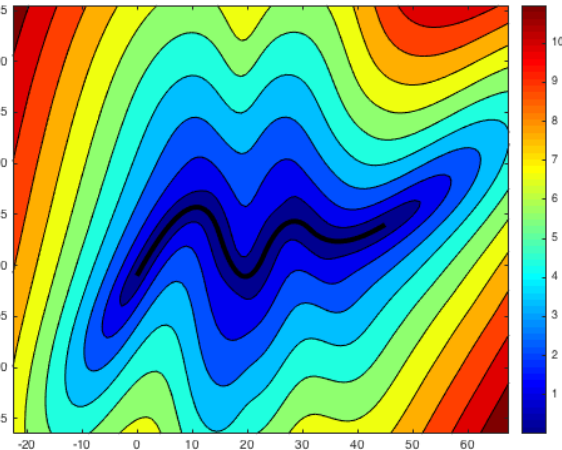
Figure 12. Algebraic level sets from an open quadratic NURBS curve. The generated algebraic level sets ensure the smoothness of the field.